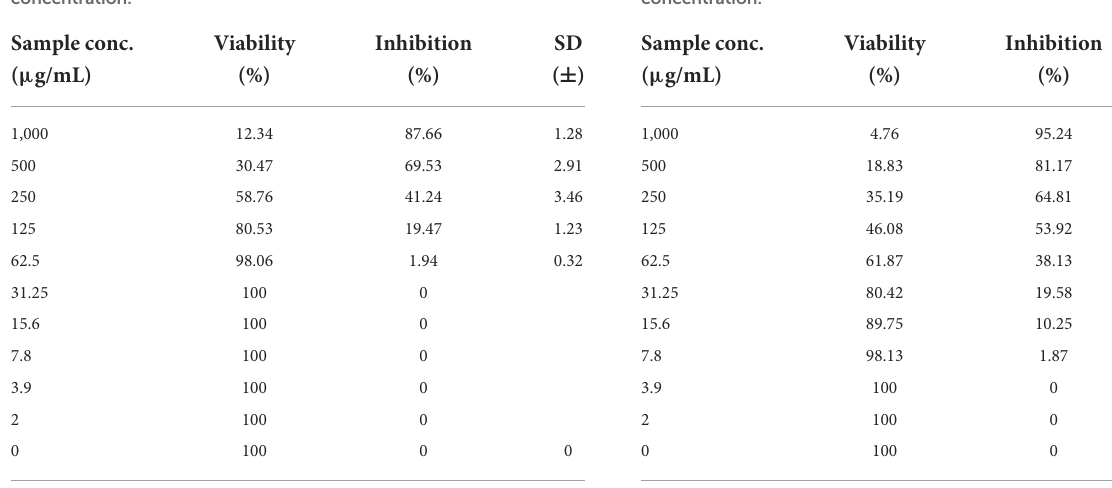
TABLE 1 Cytotoxic activity of chitosan in mammalian cells derived from African Green Monkey kidney (Vero) cells at a 50% cell cytotoxic concentration.